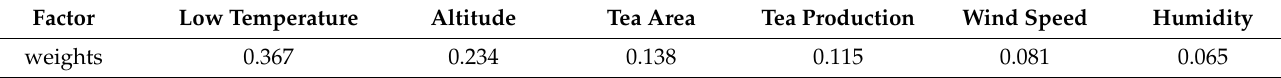
Table 3. Tea frost factor weight.